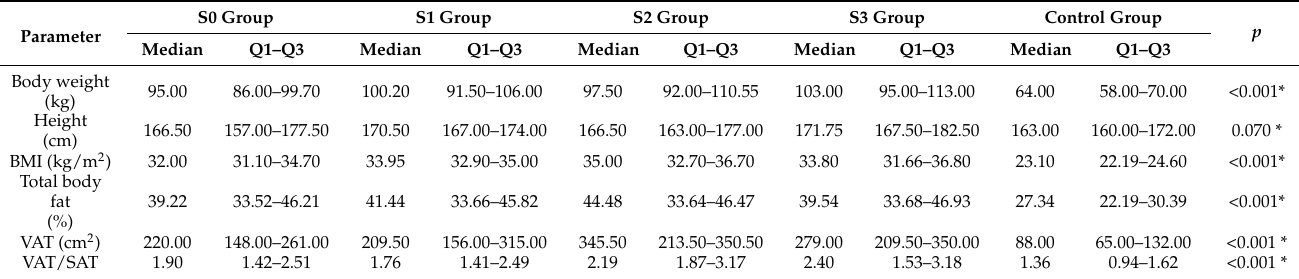
Table 1. Characteristics of anthropometric parameters and body composition of all